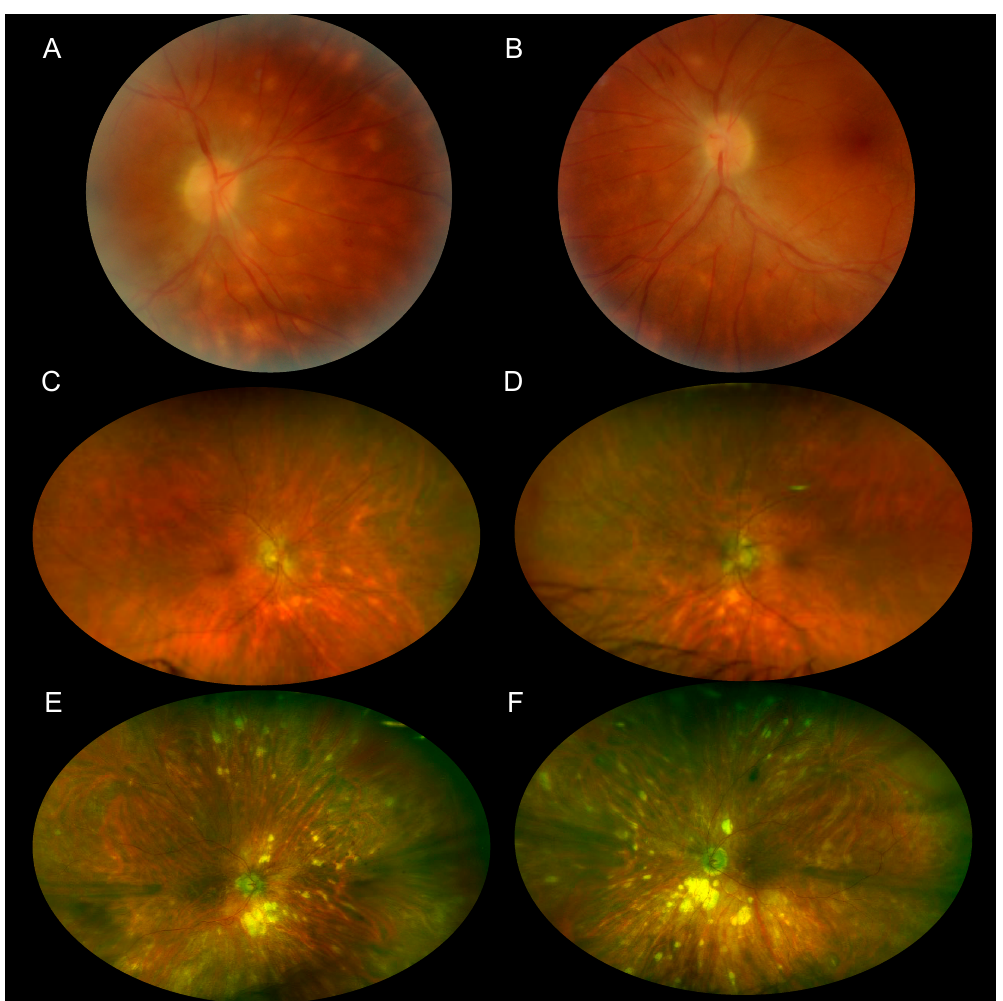
Figure 1. ( A , B ) Color fundus photography of a 38-year-old man with recently diagnosed BSCR. The round to oval birdshot lesions are concentrated inferonasally to the optic disc. ( C , D ) Wide-field color fundus photography of an 80-year-old man taken 20 years after the diagnosis of BSCR. The birdshot lesions appear as oval or linear streaks of hypopigmentation and remain more prominent inferonasally to the optic disc. ( E , F ) Wide-field color fundus photography of a 95-year-old woman taken 18 years after the diagnosis of BSCR. Birdshot lesions are ovoid in shape and appear to radiate from the optic disc. Some lesions coalesce into areas of chorioretinal atrophy predominantly nasally from the optic disc.